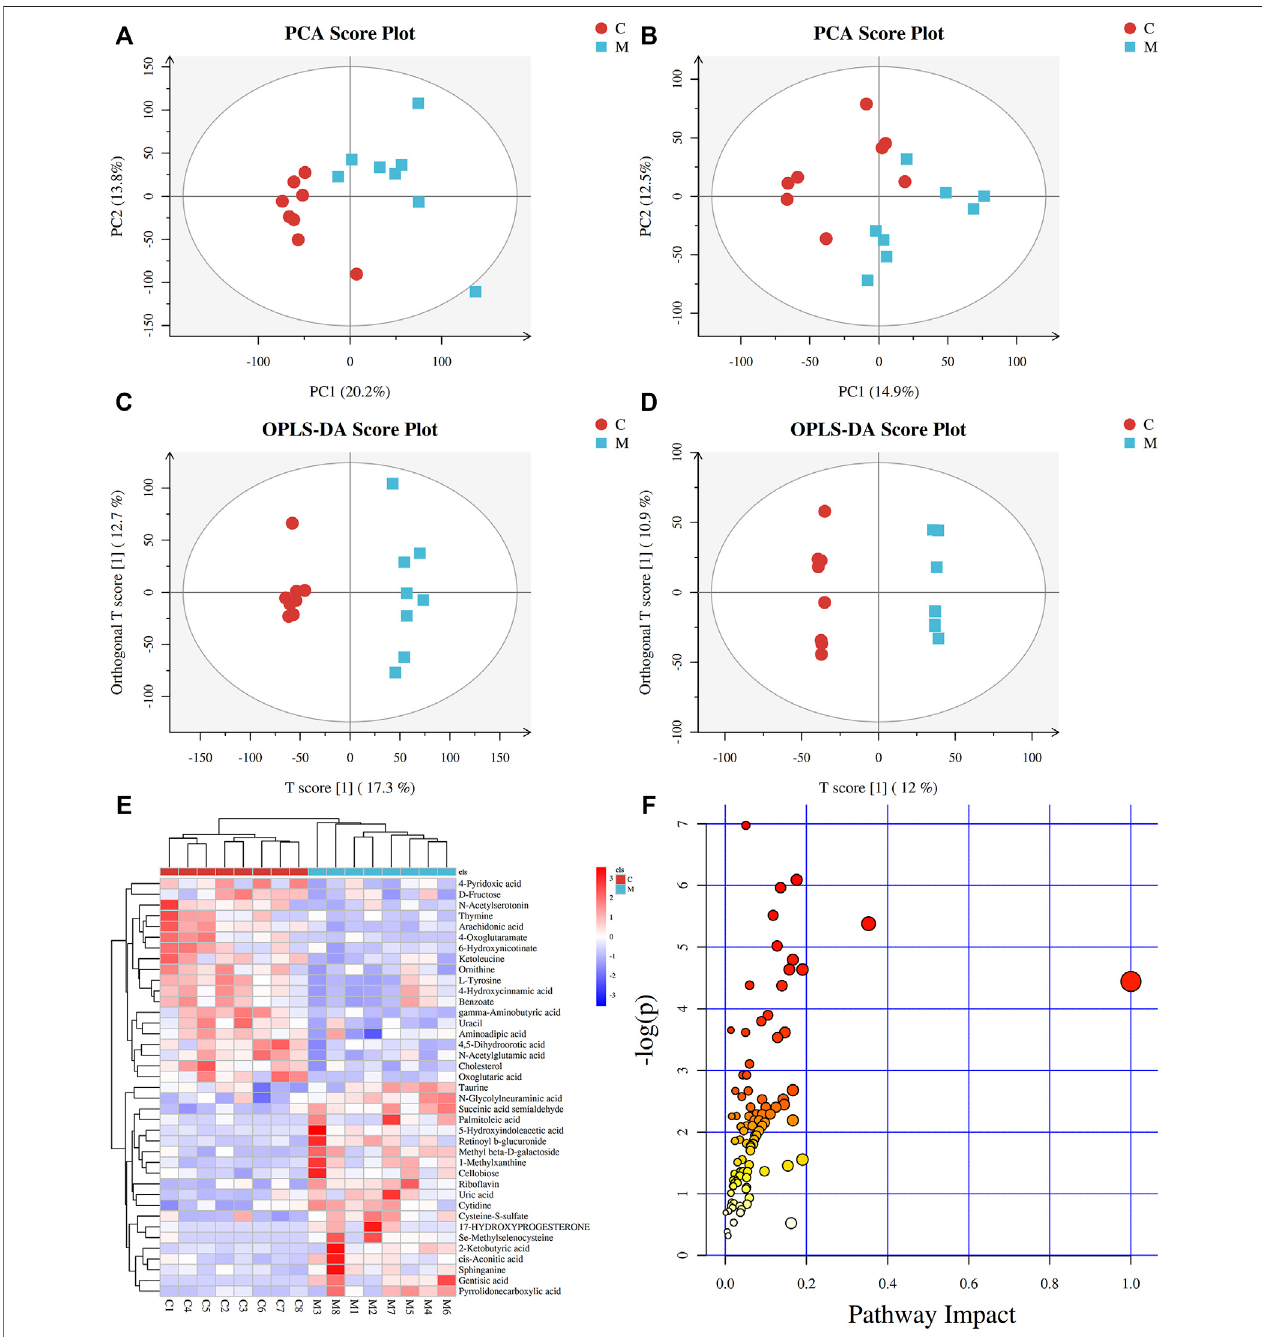
FIGURE 2 | Metabolic pro fi les of serum samples in rats with in fl ammation induced by LPS. (A) PCA score plot in positive mode; (B) PCA score plot in negative mode; (C) OPLS-DAscoreplotinpositivemode(R 2 Y=0.980andQ 2 Y=0.803); (D) OPLS-DAscoreplotinnegativemode(R 2 Y=0.999andQ 2 Y=0.680); (E) Clustering heatmaps ofdifferential metabolites betweenthe normal control(CG) and model (MG) groups. Red representshigh adjacency (positive correlation),and blue represents low adjacency (negative correlation); (F) Metabolic pathway analysis of differential metabolites between the normal control (CG) and model (MG) groups.